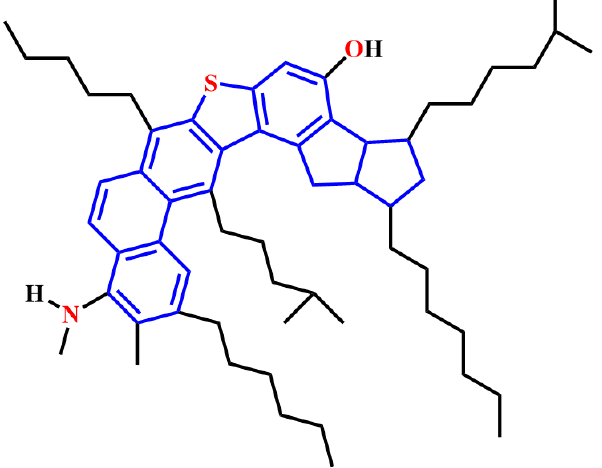
Figure 11. Typical molecular structures of resins. Reprinted with permission from Ref. [100]. Copy- right 1996, copyright the American Chemical Society.